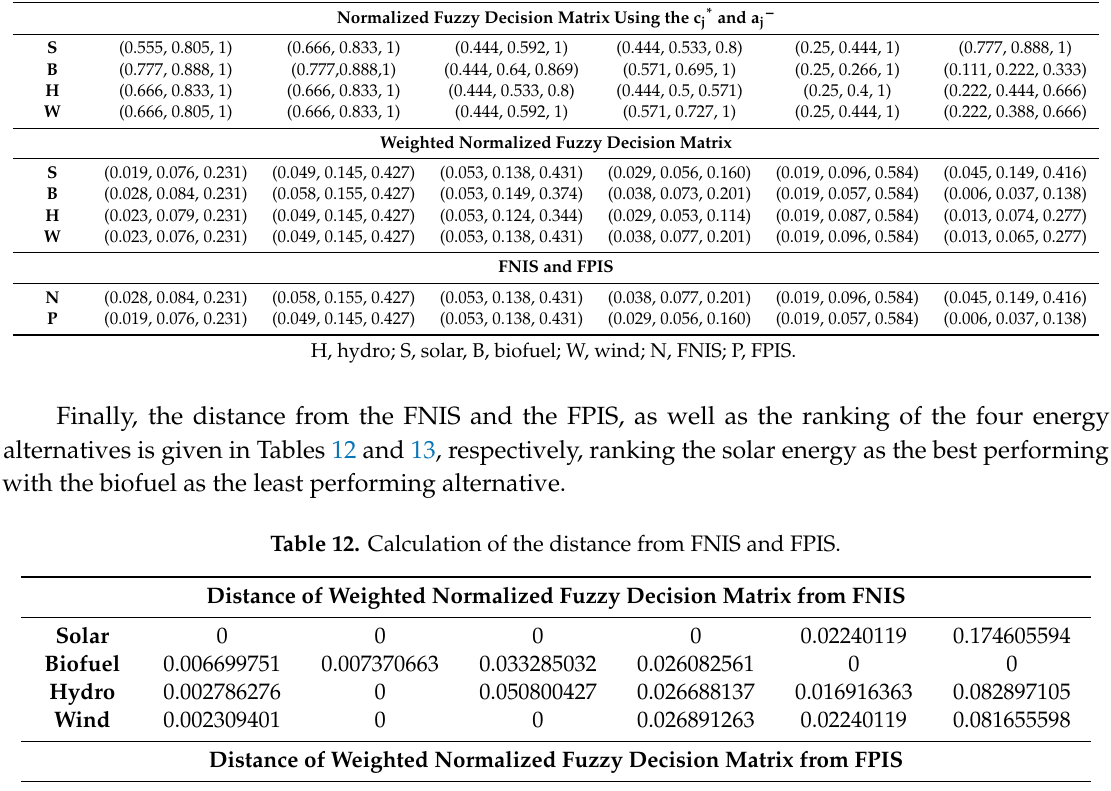
Table 11. Calculation of the fuzzy decision matrix and the fuzzy positive ideal solution (FPIS) and fuzzy negative ideal solution (FNIS).